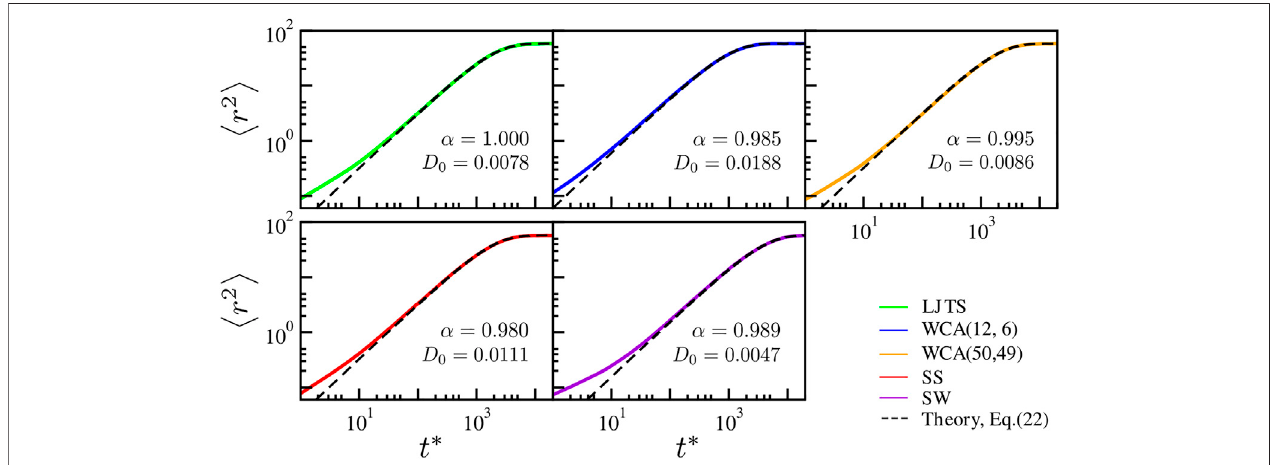
FIGURE6 | Comparison between the projected MSD obtained from simulations (colored solidlines) and theory (black lines) according to Eq. 22 . The values of the parameters used are included in each plot. The scaling factor in Eq. 17 is τ (cid:1) 1 for all